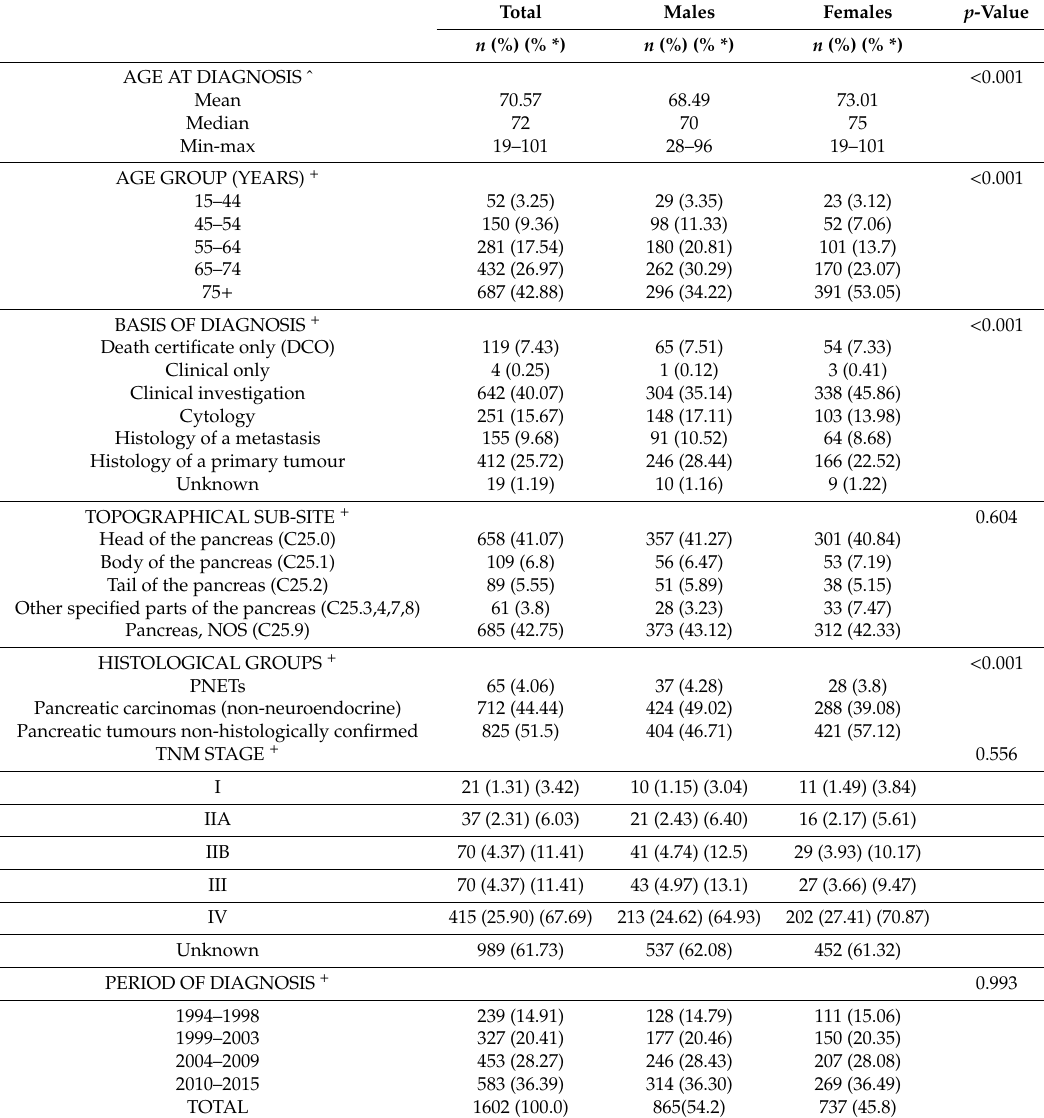
Table 1. Distribution of pancreatic tumours characteristics according to sex. Girona